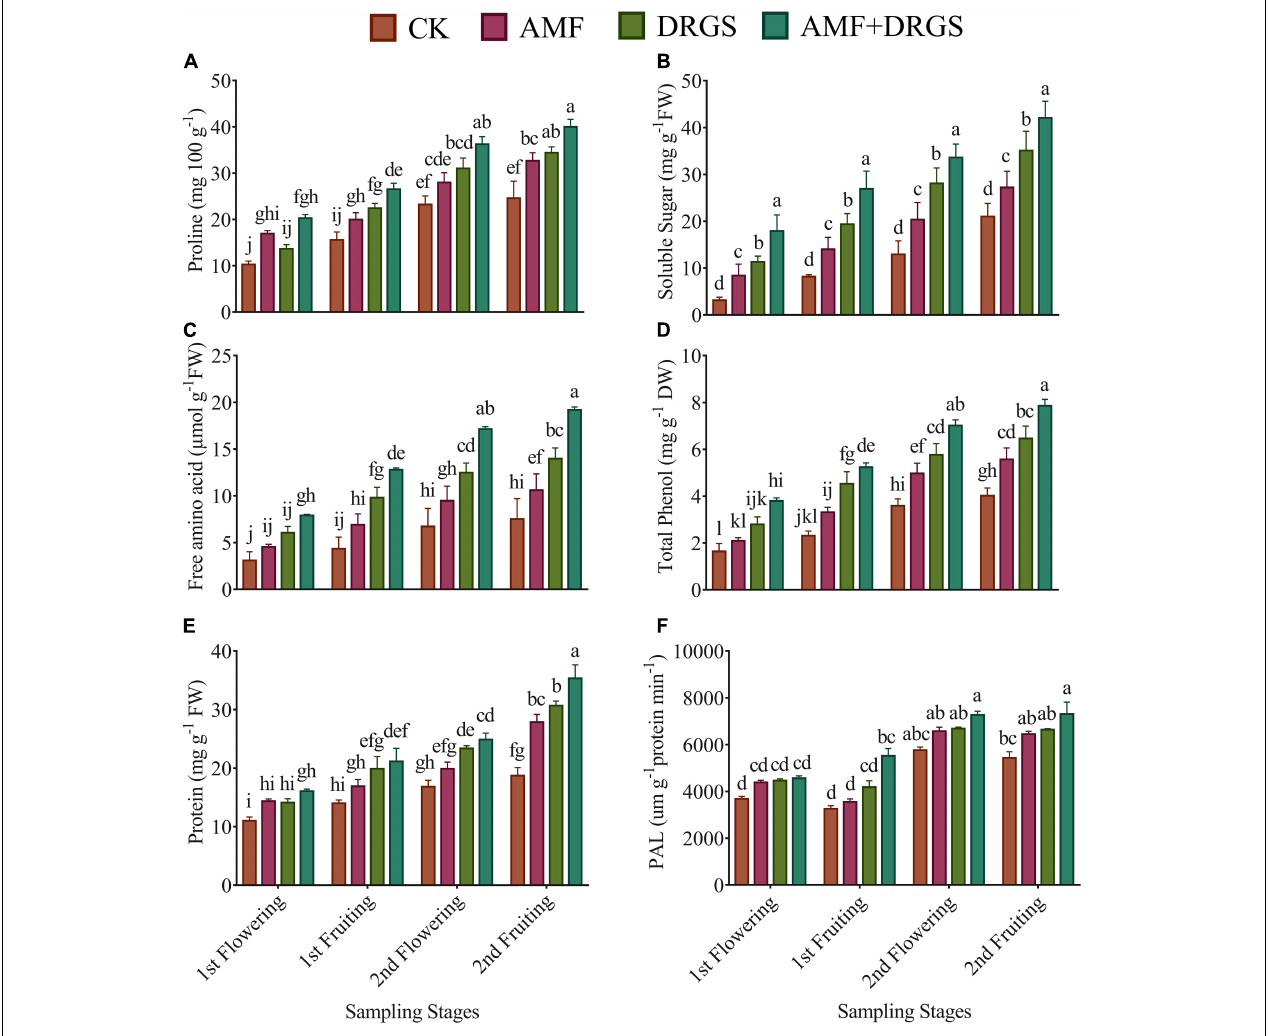
FIGURE 5 | Effect of AMF inoculation and amendment with dry raw garlic stalk on proline (A) , soluble sugar (B) and amino acid (C) total phenol (D) , protein (E) , and Phenylalanine ammonia-lyase (PAL) (F) on eggplant leaves at 1st flowering, 1st fruiting, 2nd flowering, and 2nd fruiting stages. Data represent the means of ± S.E. ( n = 5). Different letters show significant differences within treatments. Tukey’s HSD test was employed to verify statistical significance at p <